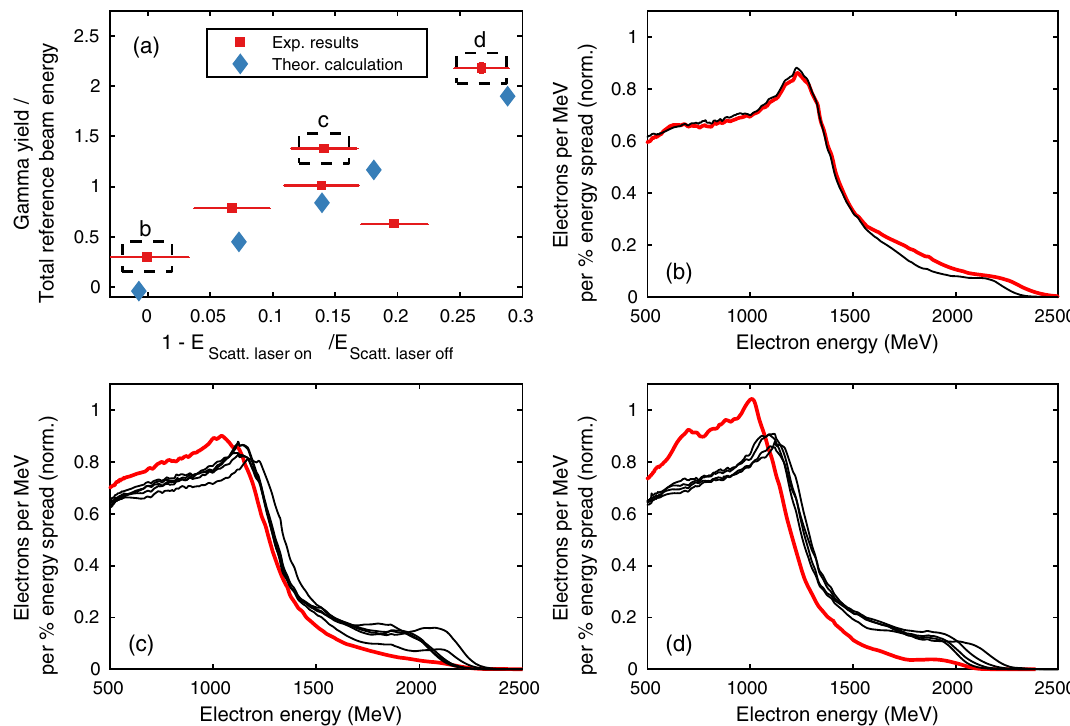
FIG. 3. Radiation reaction data. (a) Measured integrated γ -beam photon energy (background subtracted and normalized to the total kinetic energy in the unscattered electron beam) versus the amount of radiation friction experienced by the electron beam. Total friction is estimated by dividing the total kinetic energy in the scattered electron beam by the total kinetic energy in the related reference shot. (b) – (d) Measured electron spectrum after interaction with the scattering laser (thick red line) and related spectra with the scattering laser off (black thin line) for the three different scenarios shown in frame (a): poor overlap [frame (b)], moderate overlap [frame (c)], and best overlap [frame